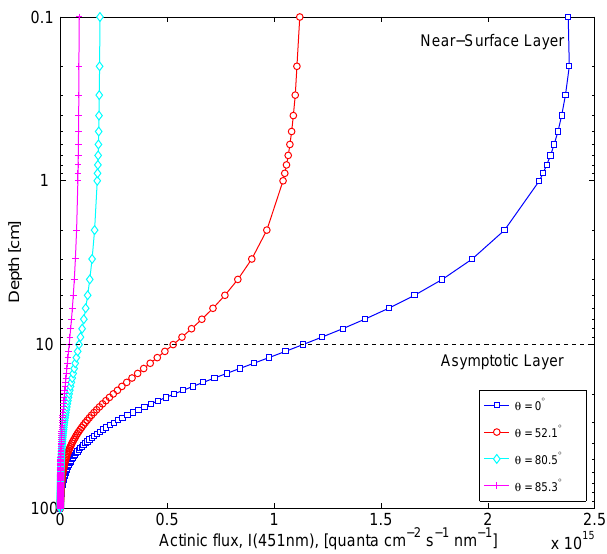
Figure 1. Depth profile within “cold polar snow” (base case: ρ =0 . 4gcm − 3 , [BC] = 4ng ( C ) g − 1 and σ scatt = 25m 2 kg − 1 ) of ac- tinic flux, I , at λ = 451nm at different solar zenith angles θ